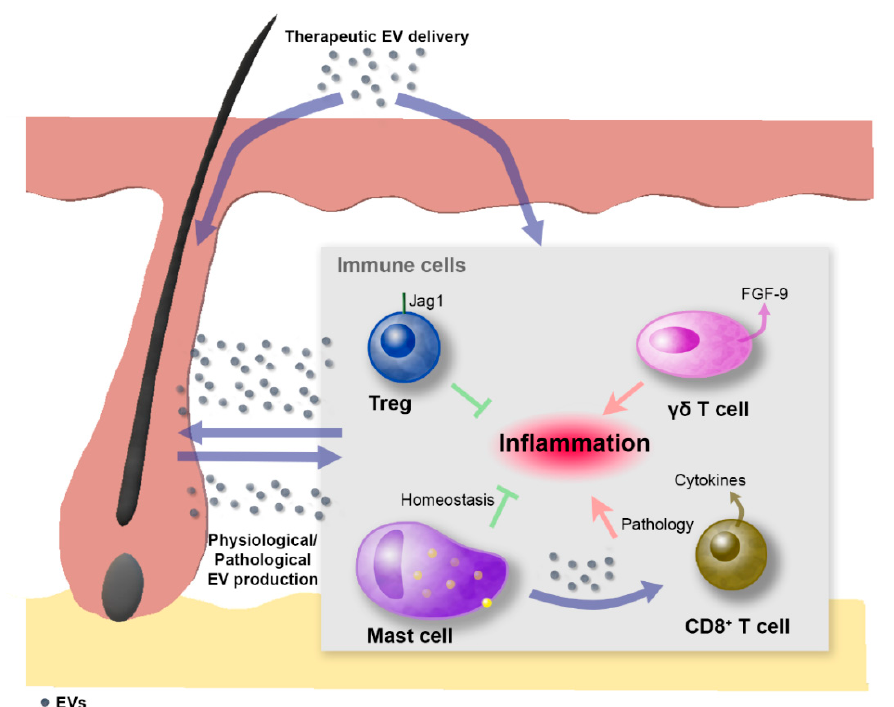
Figure 2. Extracellular-vesicle-mediated crosstalk between immune cells and hair follicles. EVs can be naturally produced under physiological/pathological conditions or, alternatively, can be therapeutically delivered. EVs can contribute to the modulation of hair follicle stem cell function by acting either directly or indirectly through their effect on immune cells. In this sense, different types of immune cells are involved in the control of hair follicle dynamics. Skin-resident regulatory T (Treg) cells that express high levels of the Notch ligand Jagged-1 (Jag1) facilitate hair follicle stem cell function and contribute to hair follicle regeneration. Skin resident mast cells contribute to hair follicle immune privilege under physiological conditions but are known to become proinflammatory in alopecia areata, in which mast cells contain less TGF- β 1 and produce exosomes that induce T lymphocytes to proliferate and secrete cytokines. The γδ -T cell population in mouse skin secretes FGF-9, which modulates hair follicle neogenesis after skin wounding. In addition, epithelial and dermal hair follicle cells can secrete EVs that potentially target other hair follicle cell populations or skin resident immune cells, contributing to the modulation of local inflammation. Purple arrows indicate the flux of EVs; red arrows indicate proinflammatory stimuli; green T bars indicate anti- inflammatory stimuli.